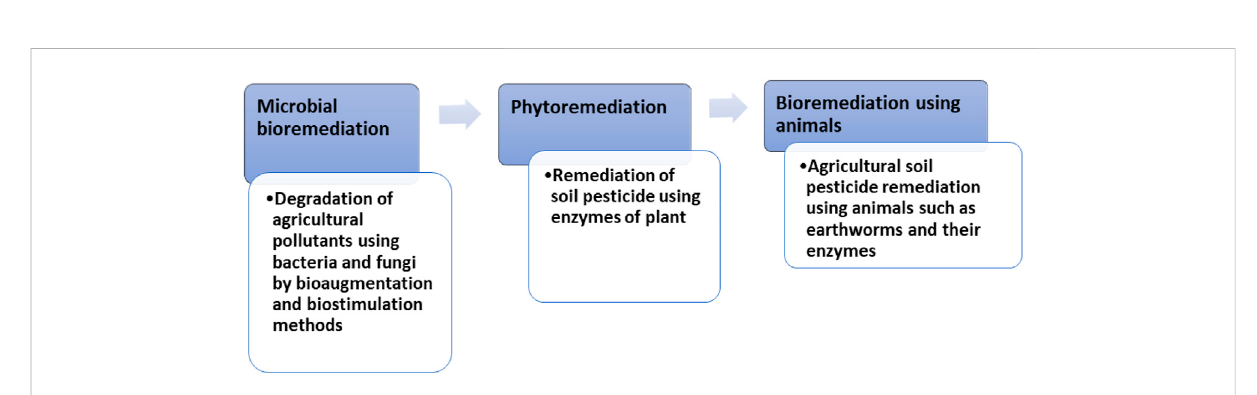
FIGURE 1 Integrative role of earthworms, plants and microbes in pesticide biodegradation.